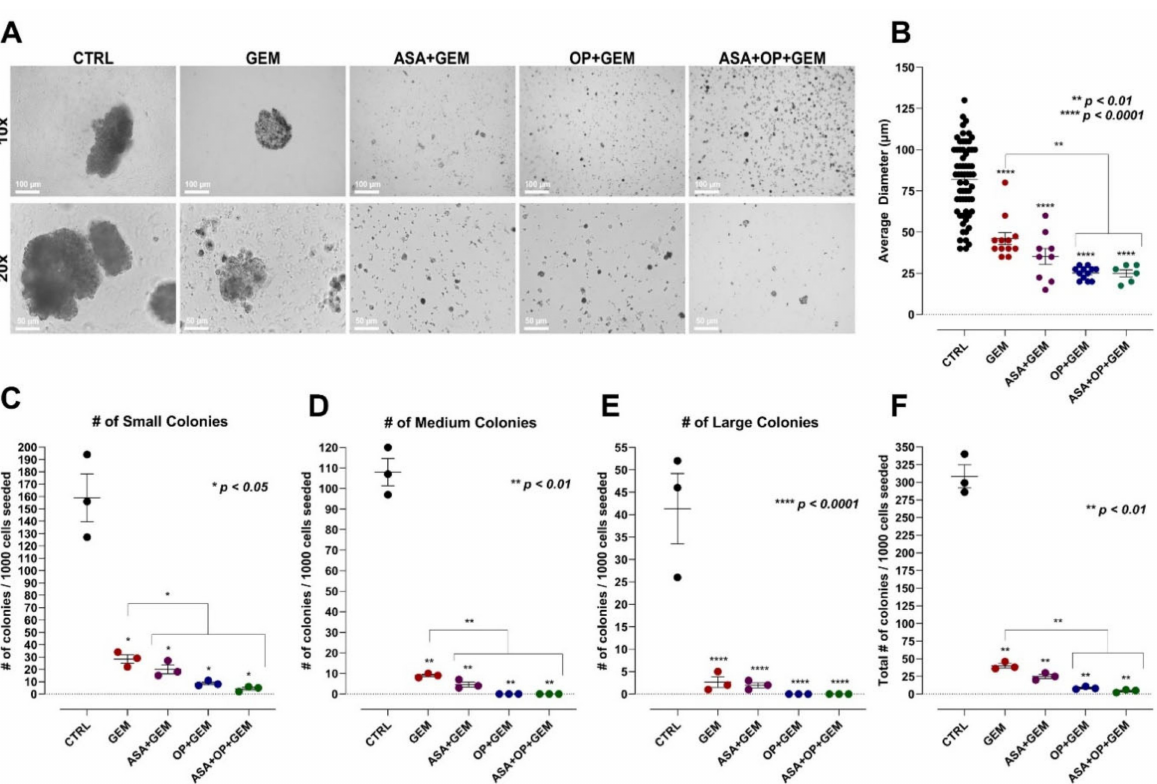
Figure 5. ASA, OP, GEM, and their combination reduce the clonogenic potential of PANC-1 pancreatic cancer cells. PANC-1 cells were treated with ASA (4 mM), OP (4.7 mM), GEM (0.338 µ M), or their combination for 7 days. Cells were counted and resuspended in methylcellulose-containing media at a density of 3000 cells/mL. Cells were plated in 35-mm tissue culture dishes and incubated for 14 days. ( A ) Images were obtained after 14 days using phase microscopy, using the 10 × and 20 × objective. ( B ) The diameter of colonies was measured using a graded dish on a phase-contrast